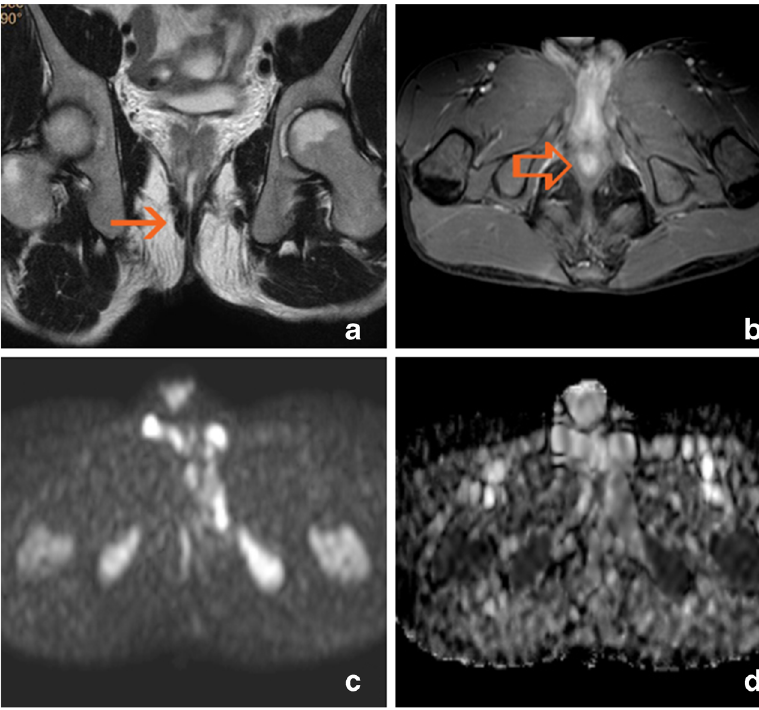
Fig. 6 Anal fibrous stenosis. The internal anal sphincter shows hypointensity on T2-weighted sequences and diffuse enhancement after gadolinium administration (arrows); the native diffusion-weighted image and the ADC map show hypointensity. a Oblique-coronal T2-weighted image. b Post- gadolinium oblique-transverse fat-supressed gradient echo T1- weighted image. c Native oblique-transverse native